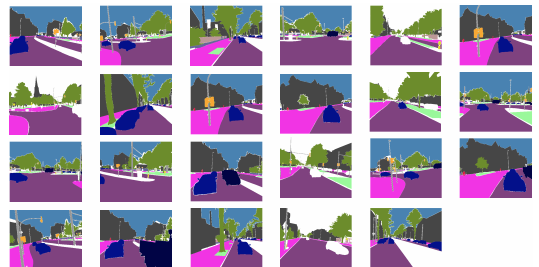
Figure 1. Manually annotated images for a subset of the MMS dataset, according to the official Cityscapes policy.